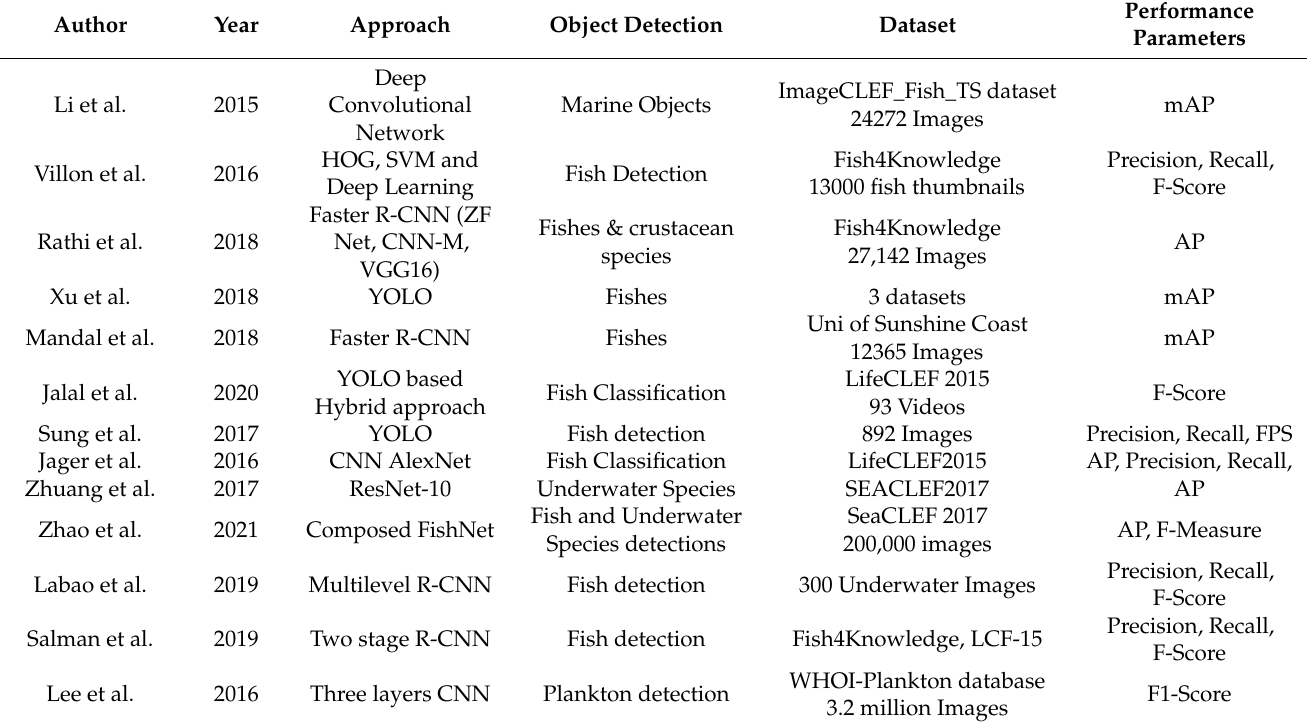
Table A1. Underwater object detection with key findings.